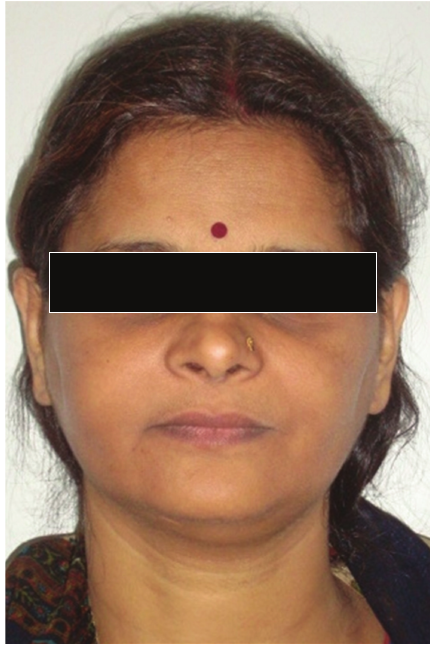
Figure 12: Panoramic radiograph (Case